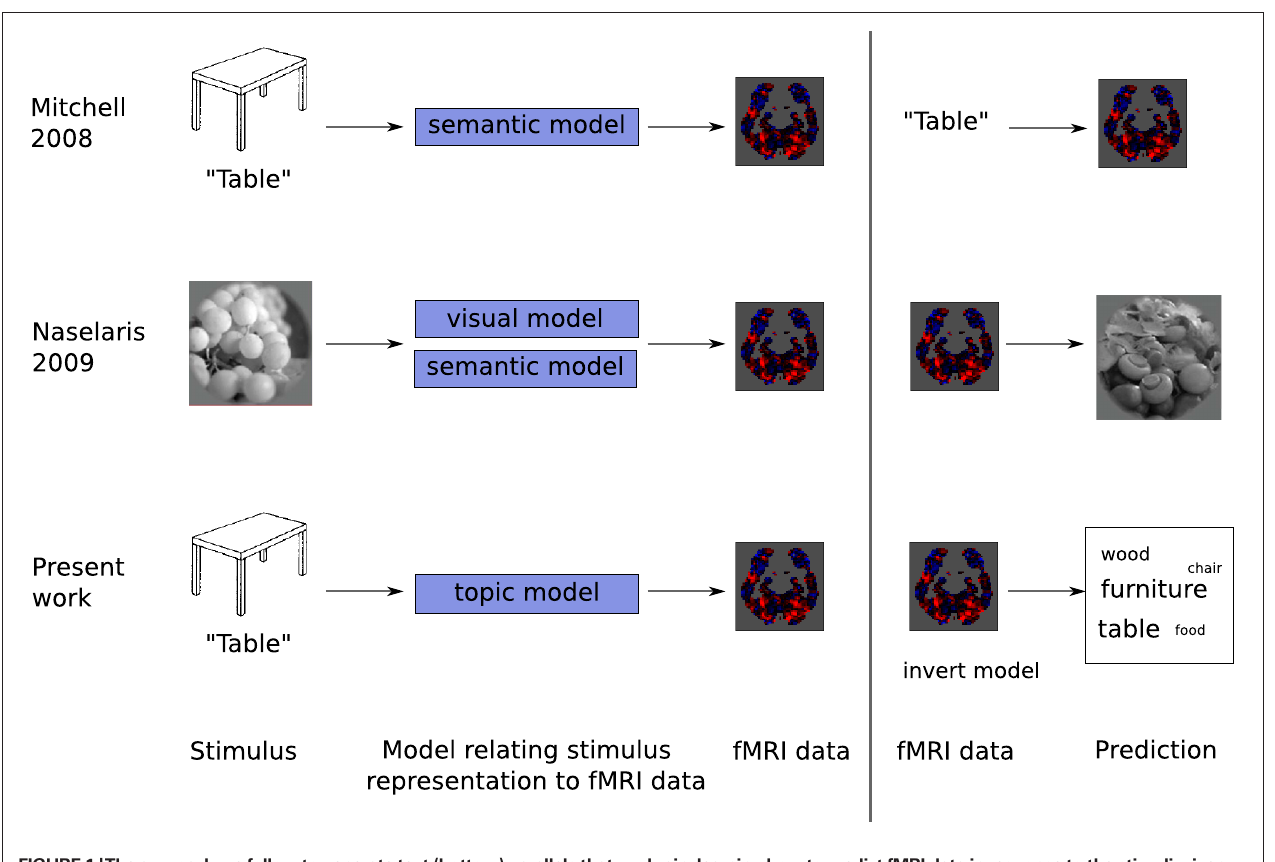
brain, learning how to predict fMRI data in response to the stimuli, given the model, and inverting the process to make a prediction for fMRI data not used to fit the